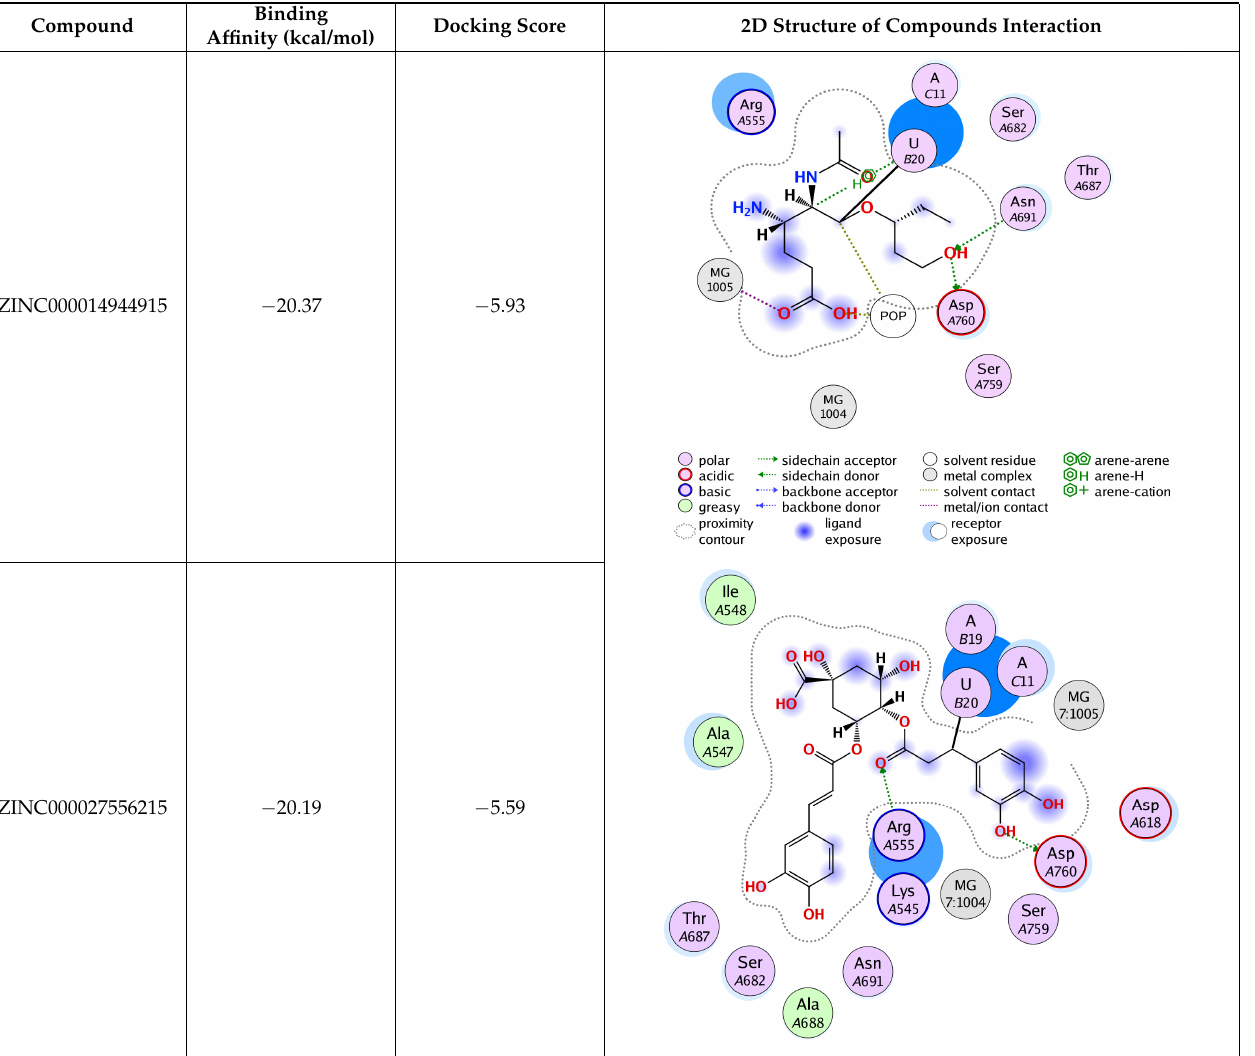
Table 2. Binding affinity, docking score and the 2D Structure of the potential hits’ interactions with RdRp of SARS-CoV-2.